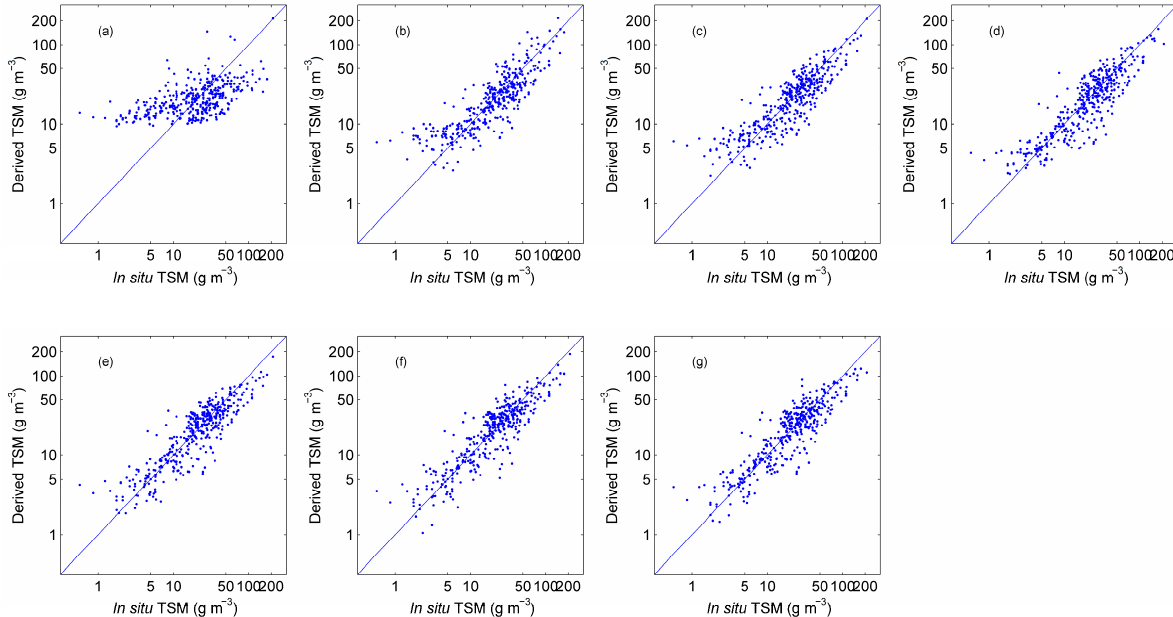
Figure 3. The suspended sediment distribution derived using different algorithms (Equations (7) to Equation (4)). The scene was captured on 16 November 2014.